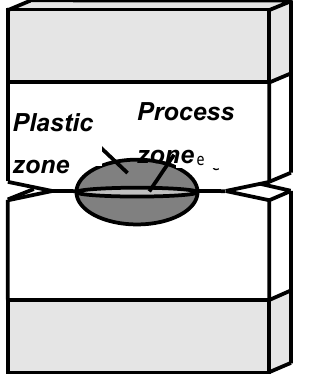
Figure 9. Process and plastic zones involved in a notched specimen under